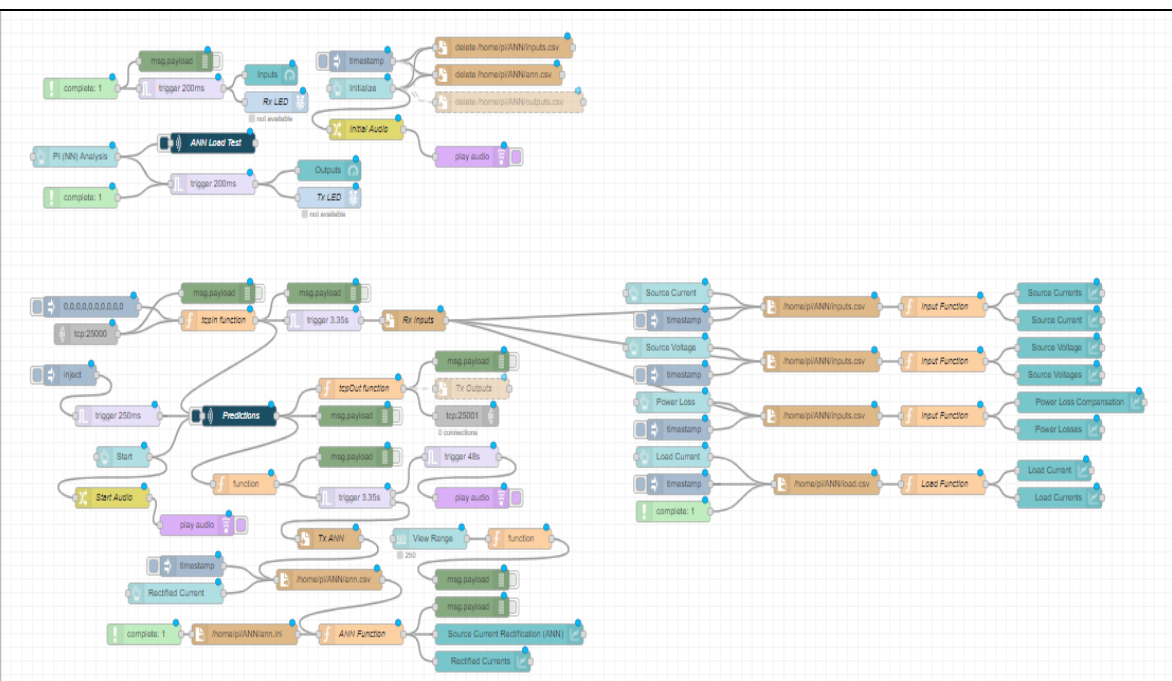
Figure 33. Backend Serial Socket Communication Nodes.